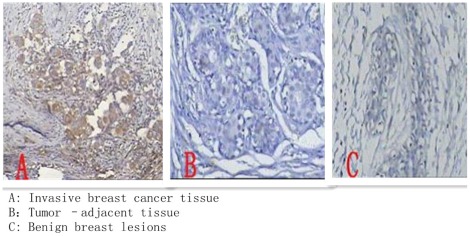
Shows the expression of IGF-2 in different tissues.
Figure 1A : Shows the expression of IGF-2 in the invasive breast cancer tissue. Figure 1B: Shows the expression of IGF-2 in the tumor –adjacent tissue. Figure 1C : Shows the expression of IGF-2 in the benign breast lesion tissue.